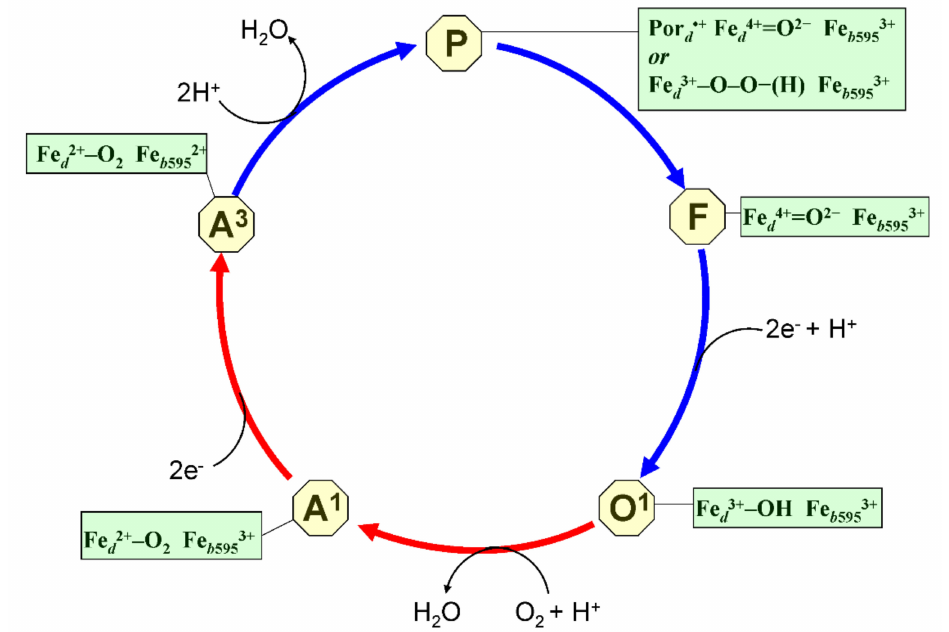
Figure 4. Catalytic cycle of bd -type oxidase. Shown are catalytic intermediates (O 1 , A 1 , A 3 , P, F), and the proposed structure of a di-heme active site for each intermediate. The cycle can be divided into two parts, reductive and oxidative. The reductive part comprises transitions from O 1 to A 3 . The oxidative part comprises transitions from A 3 to O 1